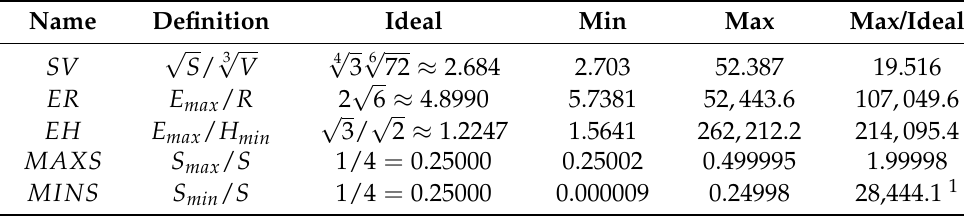
Table 6. Mesh quality of the real 3D model − the worst